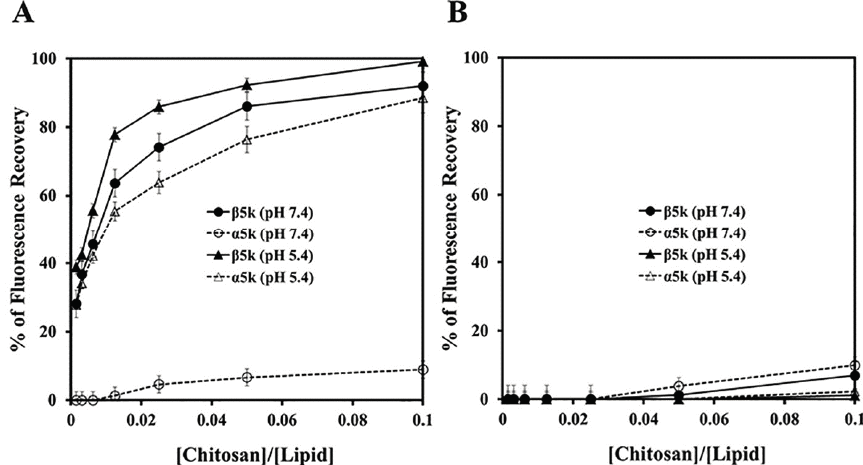
Figure 3. Rhodamine le a kage in L - α -phosphatidylethanolamine (PE)/ L - α -phosphatidylglycerol